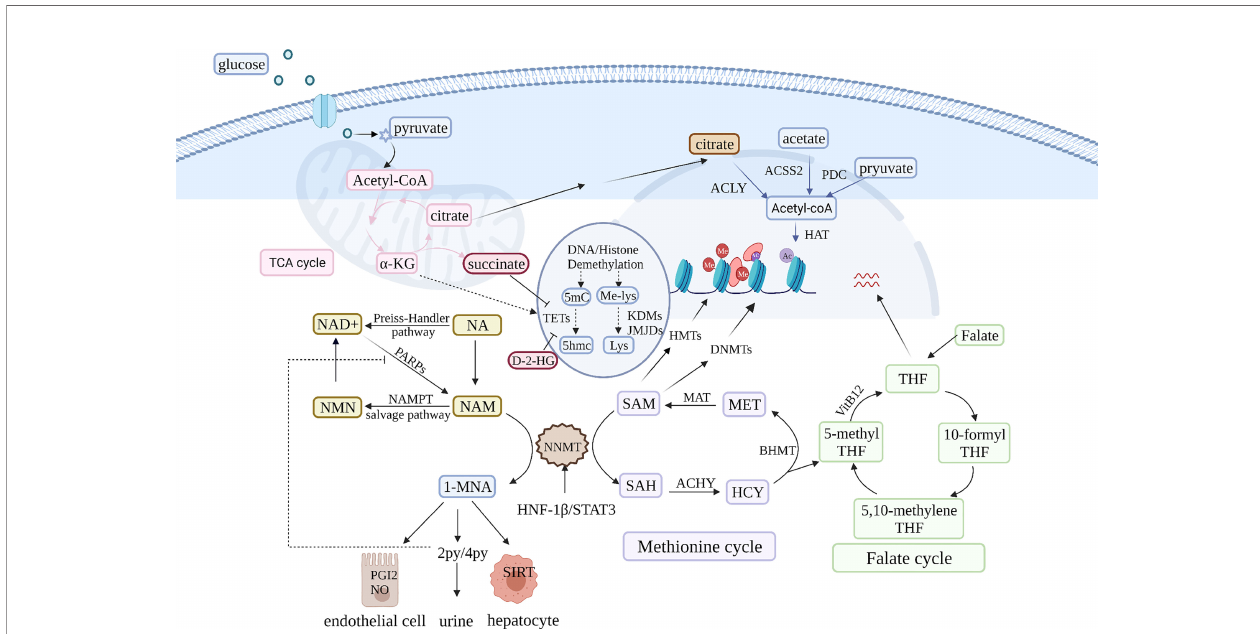
FIGURE 2 | NNMT is pivotal in NAM and SAM metabolism. NNMT uses the universal methyl donor SAM and converts NAM into 1-MNA, which oxidized to 2PY and 4PYand eventually eliminated in the urine. NNMT overexpression leads to a dual drain of NAM and SAM in cancer cells. On one hand, it affects the regeneration of NAD + , a coenzyme of various glucose metabolism enzymes. NNMT over expression decreases NAD + and contributes to glucose metabolism disorders. The glucose metabolism intermediate a -ketoglutarate ( a -KG) is a cofactor of the ten-eleven translocation methylcytosine hydroxylases (TET) and Jumonji C demethylases family (JMJC HDM), which are involved in DNA and histone demethylation, respectively. Furthermore, some glucose metabolism products can enter the nucleus and affect epigenetics. On the other hand, deleting the methyl donor SAM contributes to global hypomethylation and affects the expression of a variety of cancer-associated genes. NNMT also can regulate methyl donor balance by interacting with some enzyme in methionine cycle. In addition to NAM and SAM metabolism, 1-MNA can directly increase Sirt1 protein expression independent of its mRNA level. Sirt1, a regulator of gluconeogenesis and cholesterol synthesis is closely related to NAD + metabolism. Therefore, NNMT is a pivot in multiple metabolism cycles and in fl uence cancer metabolism from many